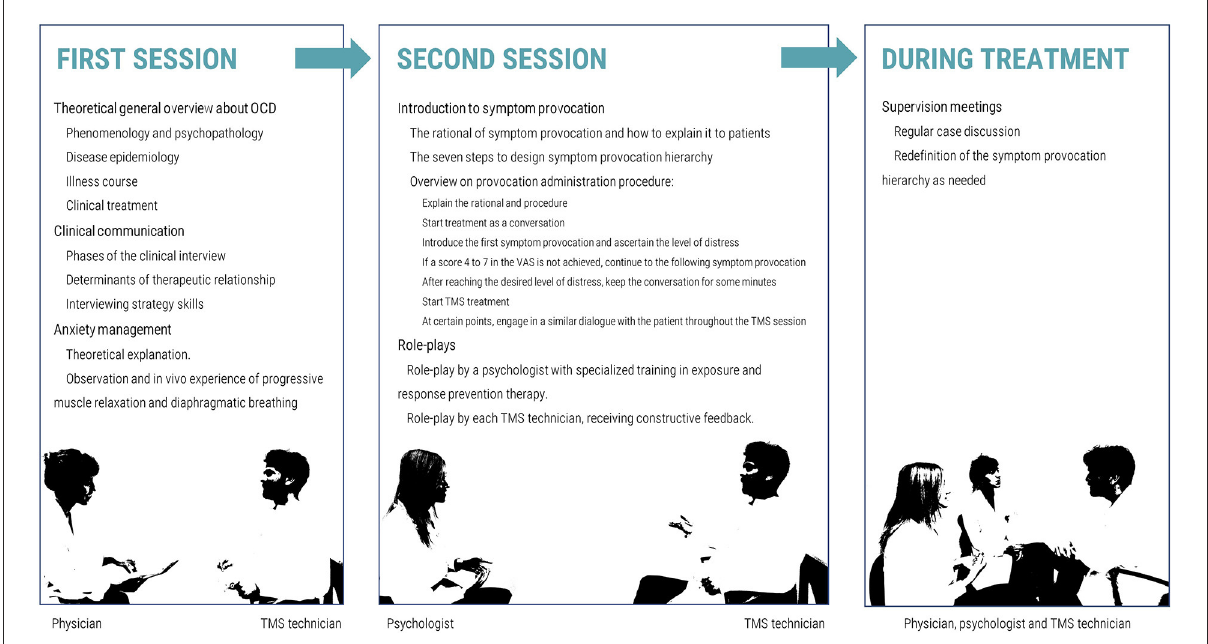
FIGURE1 Diagram illustrating the two-session model for training in symptom provocation.